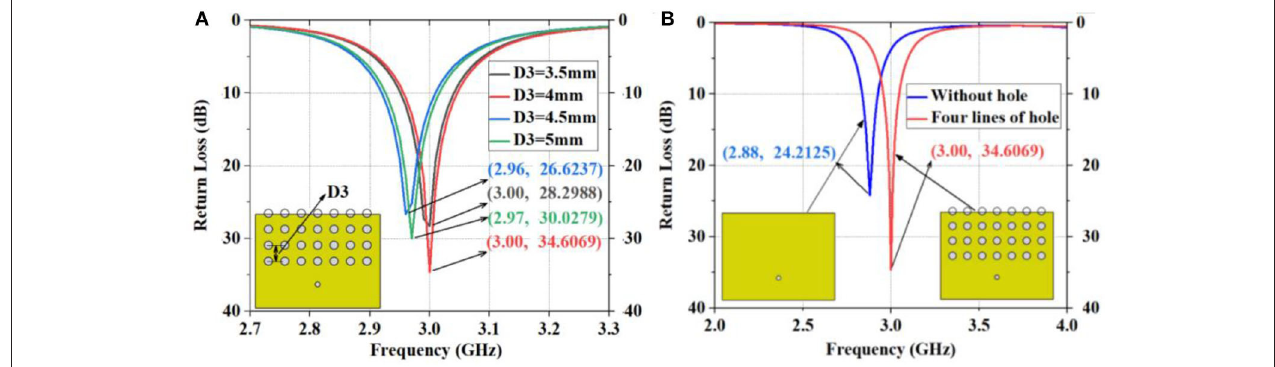
FIGURE 7 | The simulation of D3 as well as four-line and one-line holes. (A) The different dimensions of D3, (B) Comparison between the unperforated antenna and the antenna with four-row holes.